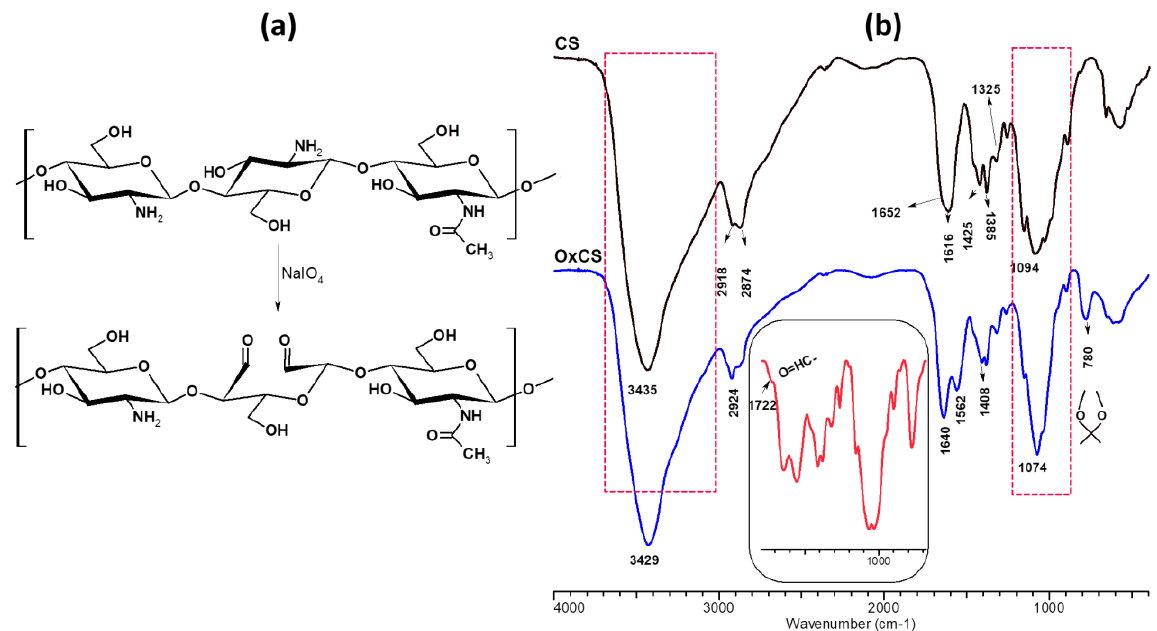
Figure 3. Schematic representation of CS oxidation ( a ) and FT-IR/ATR spectra of CS and OxCS ( b ).